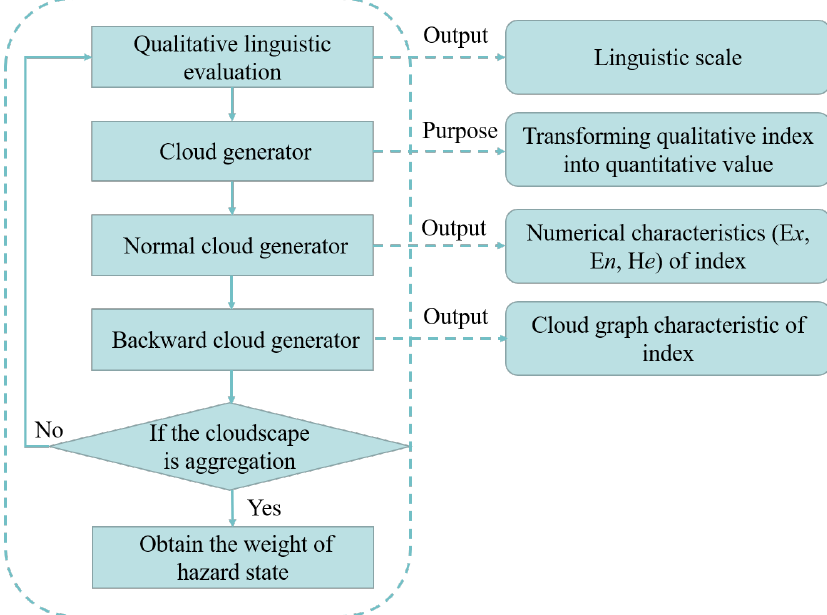
Figure 3. The steps of weight determination.